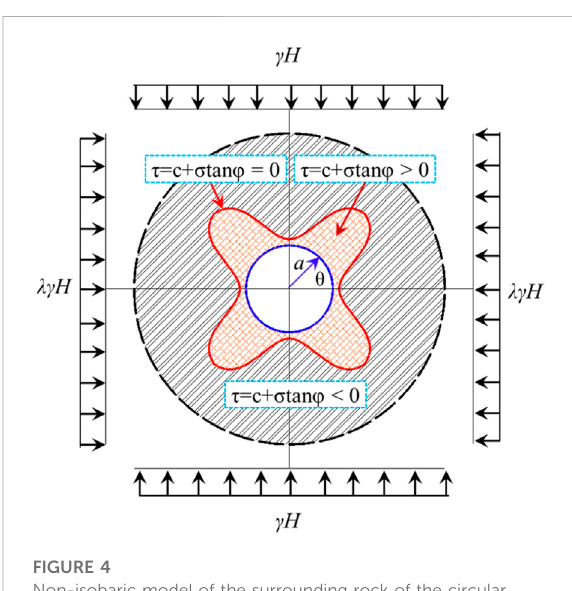
FIGURE 4 Non-isobaric model of the surrounding rock of the circular